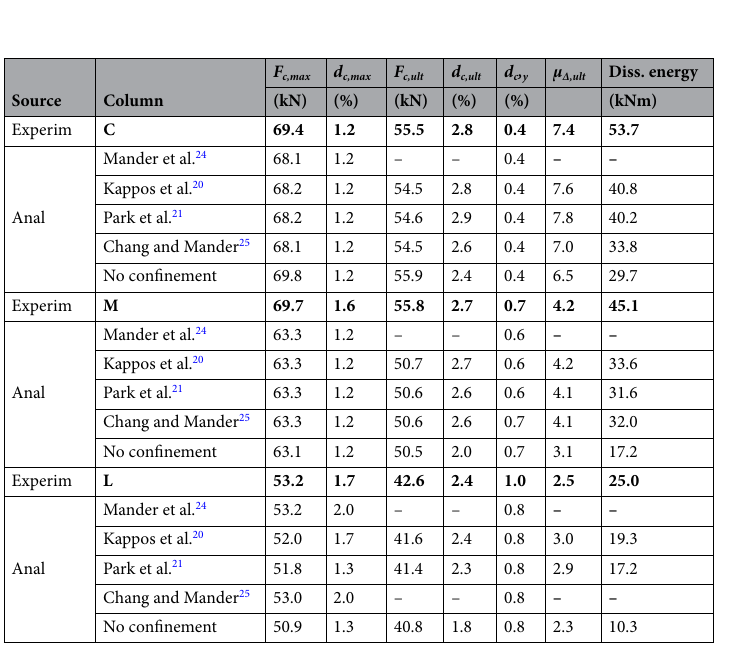
Table 6. Maximum and ultimate lateral force and corresponding drift, drift at yield strength and ductility at ultimate strength (for 16 × 16 mesh). Experimental values are in bold.